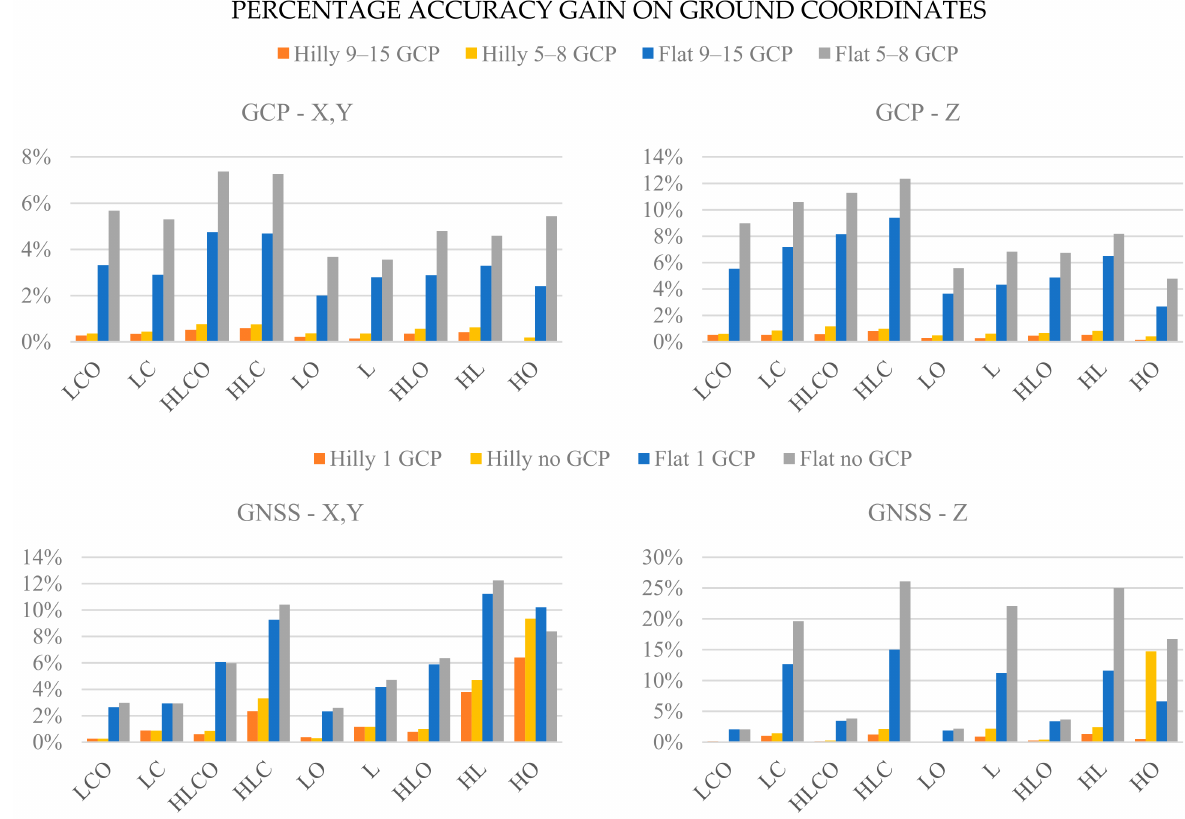
Figure 10. Percentage accuracy gain of the tie points’ ground coordinates when measurement error standard deviations in the MC simulations decrease from 3 cm for CS, 0.5 cm for GCP and 1 pixel for image coordinates (Medium precision in Table 4) to 1 cm, 0.17 cm and 0.33 pixel, respectively (High precision in Table 4). ( Top ): GCP control case; ( bottom ): GNSS control